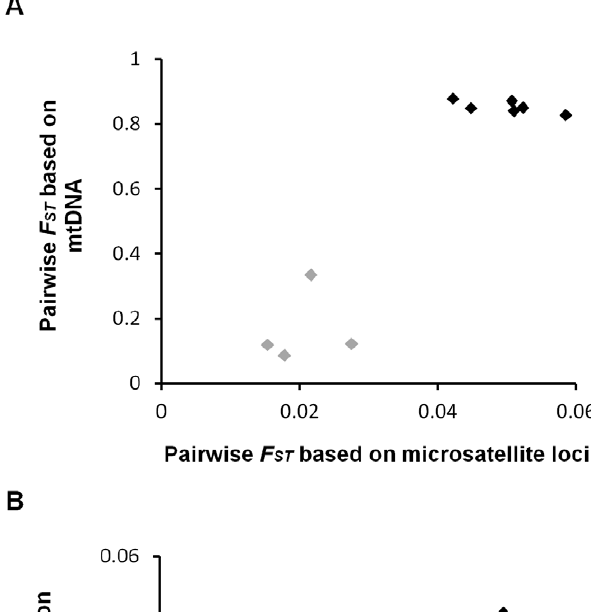
Figure 2. Between-populations pairwise genetic differentiation values ( F ST ) comparisons. (A) Comparisons between mitochondrial haplotypes and microsatellite loci, (B) between Clock poly-Q locus and mitochondrial haplotypes and (C) between Clock poly-Q locus and microsatellite loci. Points in black represent comparisons between the erythrogaster subspecies to either the rustica or transitiva subspecies, while points in grey represent comparison within the erythrogaster subspecies and between the rustica and transitiva subspecies (which are mitochondrially intermixed).